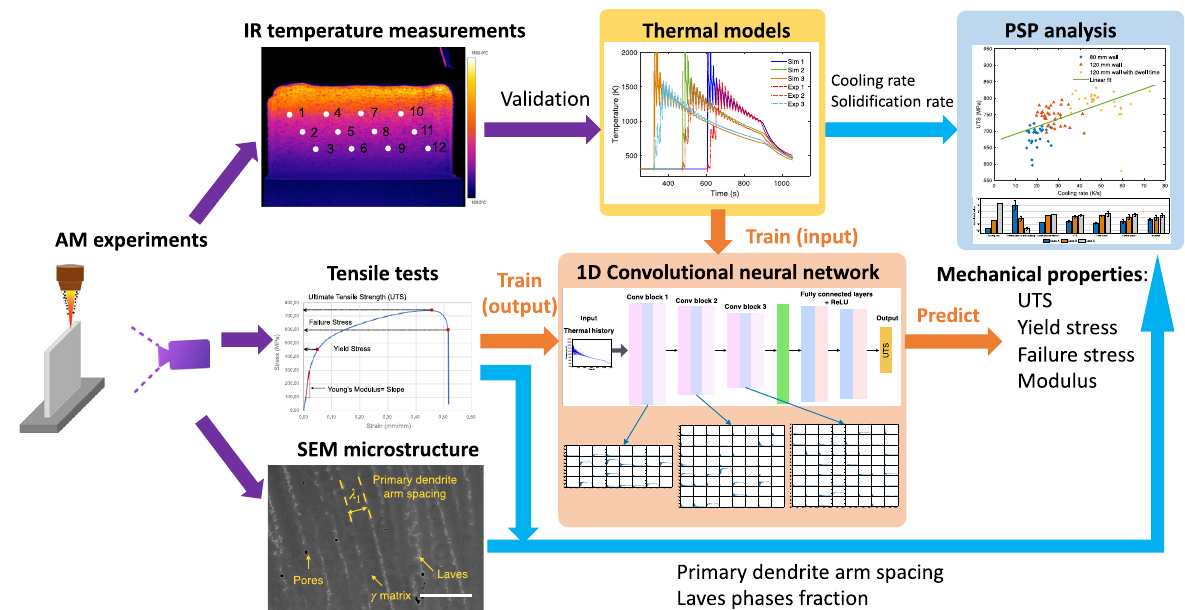
Fig. 1 Overview of the data-driven analysis for process-structure-properties. The 1D convolutional neural network is used to predict mechanical properties from simulated thermal history. The simulated thermal process data, microstructure, and measured mechanical properties are analyzed for process-structure-properties (PSP)